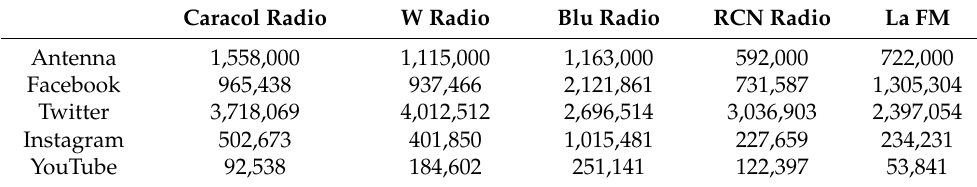
Table 1. Radio and its social followers.